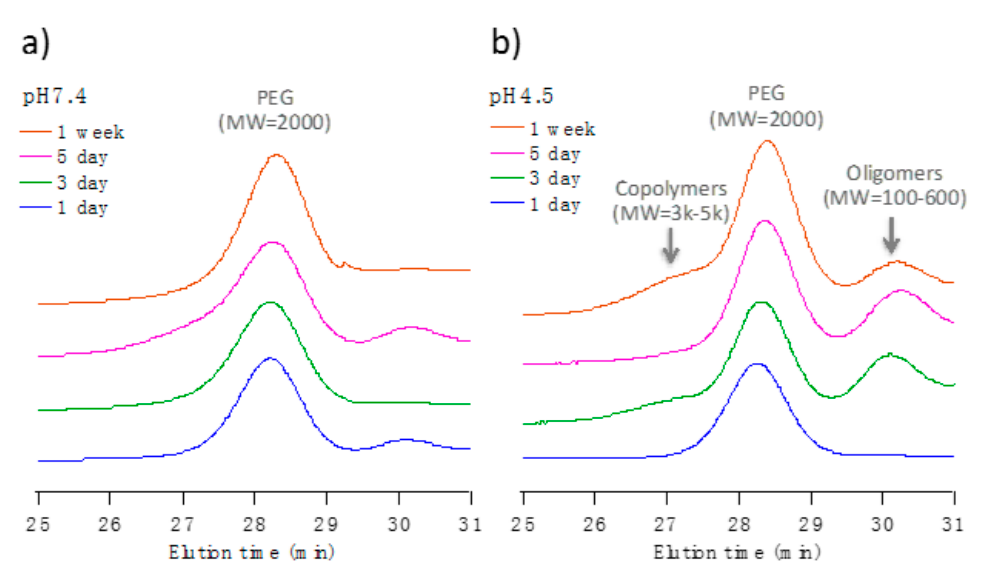
Figure 9. GPC profiles of the supernatants at ( a ) pH 7.4 and ( b ) pH 4.5, after lyophilized and re-dissolved in THF.